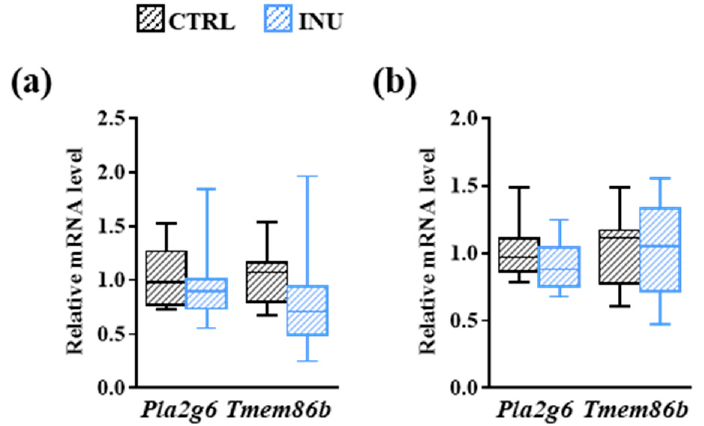
Figure 5. Effect of inulin on the expression of gene-encoding enzymes involved in the degradation of plasmalogens. Liver ( a ) and cortex ( b ) expression of genes encoding phospholipase A(2) ( Pla2g6 ) and lysoplasmalogenase ( Tmem86b ) in mice fed a control diet or a diet supplemented with inulin. The levels of mRNA were normalized to Hprt mRNA level for calculation of the relative levels of transcripts. mRNA levels are illustrated as fold change. Data are presented in box and whisker plot format (median, min. to max.). Mann-Whitney test for comparison of the level of each mRNA between CTRL and INU mice.